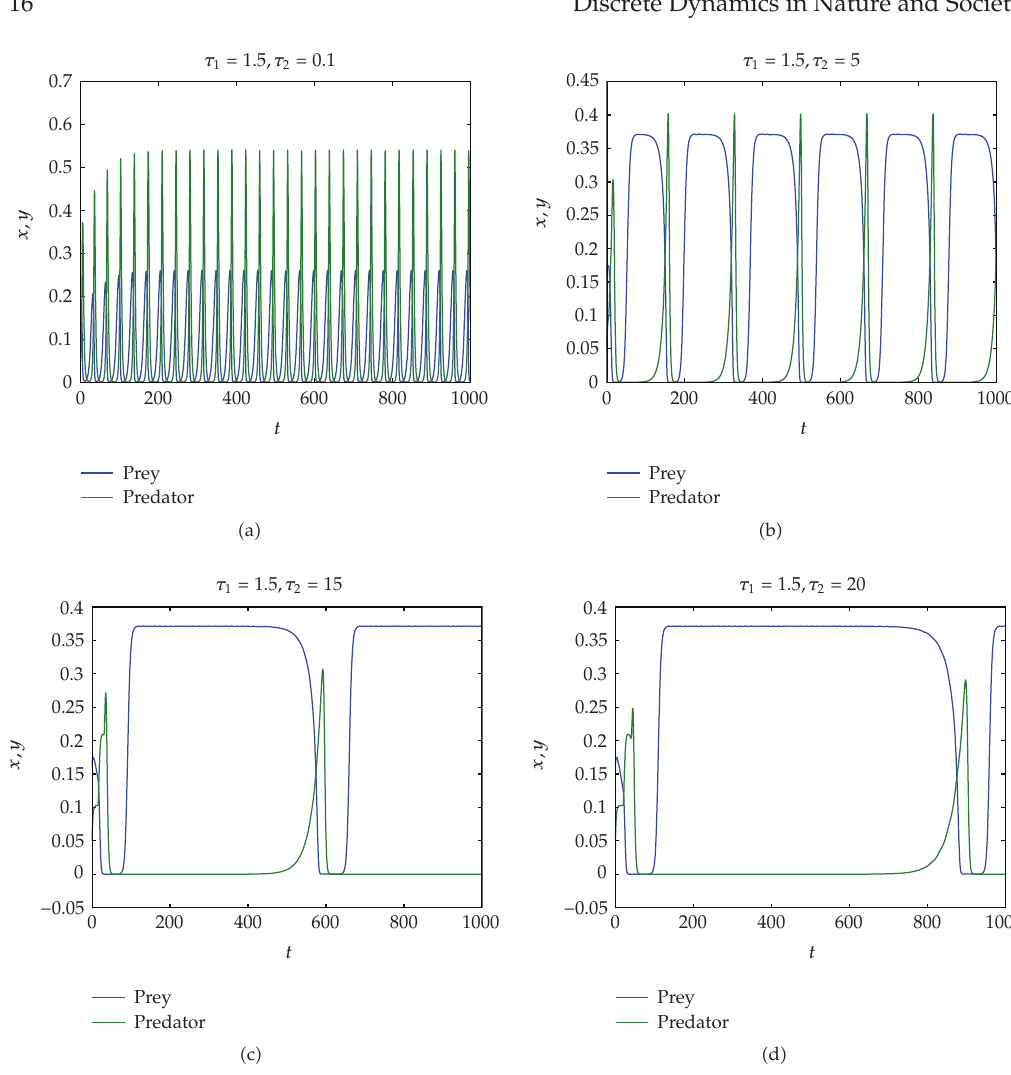
Figure 3: A solution of model (cid:4) 1.7 (cid:5) with initial conditions (cid:4) 0.16, 0.05 (cid:5) , where a (cid:8) 1 . 4, b (cid:8) 1 . 1, d (cid:8) 0 . 5, e (cid:8) 0 . 05, l (cid:8) m (cid:8) d 1 (cid:8) d 3 (cid:8) 0 . 5, d 2 (cid:8) 0 (cid:4) i.e., no mortality among the immature predators (cid:5) , τ 1 (cid:8) 1 . 5, and τ 2 varies from 0.1 to